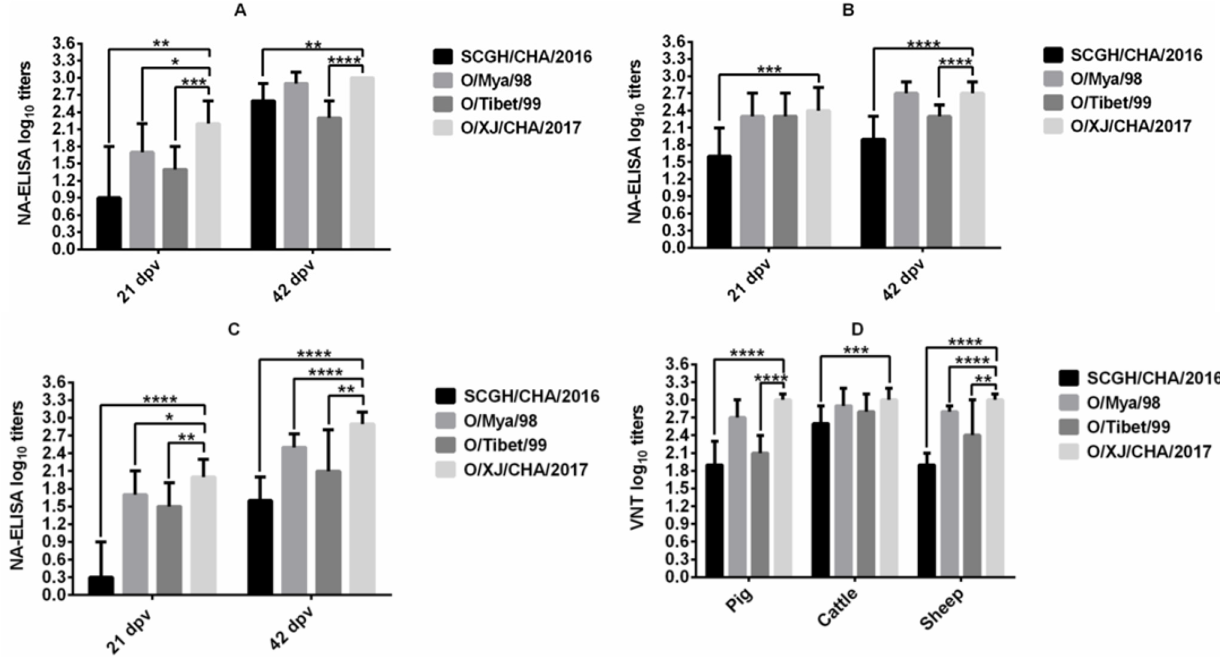
Figure 2. Cross-neutralization analysis. Serum samples collected at 21 dpv and 42dpv from pigs ( A ), cattle ( B ), and sheep ( C ) vaccinated with O/XJ/CHA/2017 vaccine were used to measure homologous antibodies with FMDV O/XJ/CHA/2017 and heterologous antibodies with FMDV O/Mya/98, SCGH/CHA/2016, and O/Tibet/99 by NA-ELISA, and sera collected at 42 dpv were also used to detect homologous and heterologous antibodies by VNT ( D ). Unpaired t -test was used to compare the differences between homologous antibodies and heterologous antibodies. * p < 0.05, ** p < 0.01, *** p < 0.001, **** p <